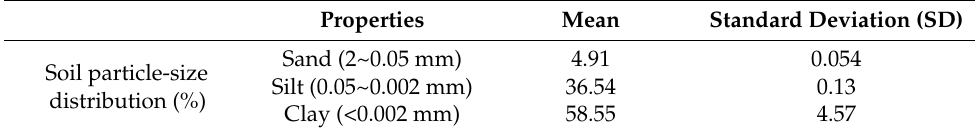
Table 1. The statistics of the soil particle-size distribution.